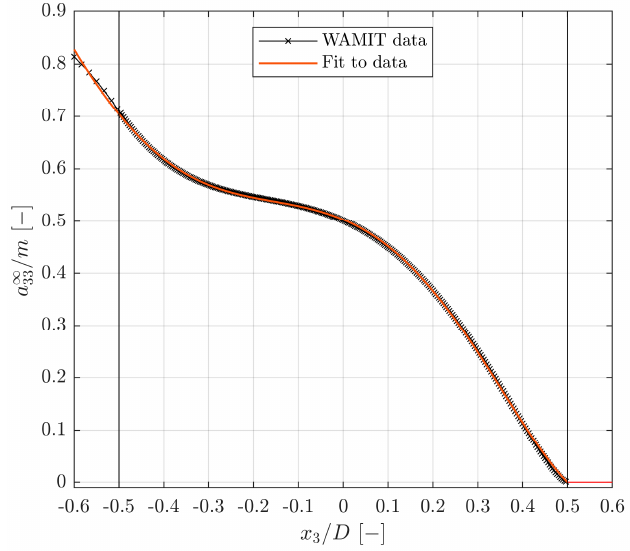
Figure A4. Draft-dependent normalized added mass at infinite frequency with a fifth order poly- nomial fit.